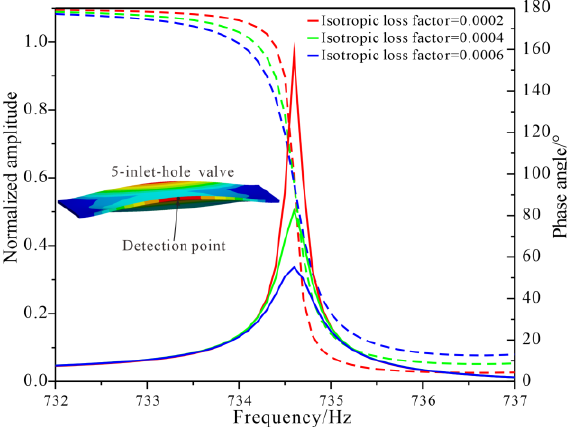
Figure 3. Frequency responses of the five-inlet-hole PDMS valve by harmonic analysis.